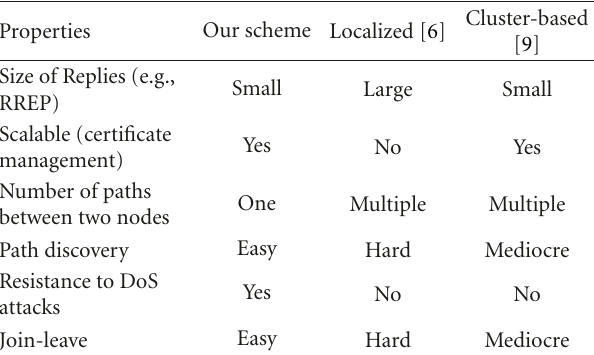
Table 1: Comparison between schemes.